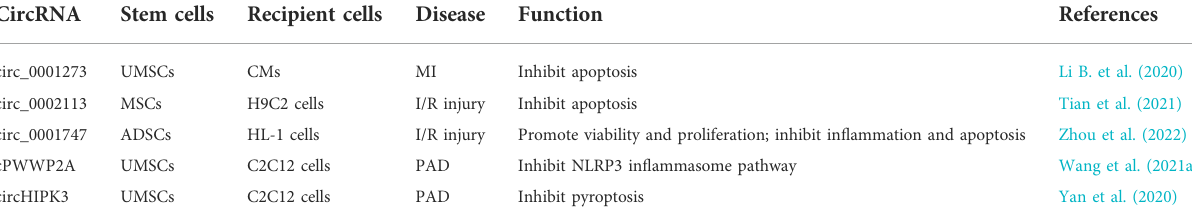
TABLE 2 The therapeutic role of stem cell-derived exosomal circRNAs in cardiovascular